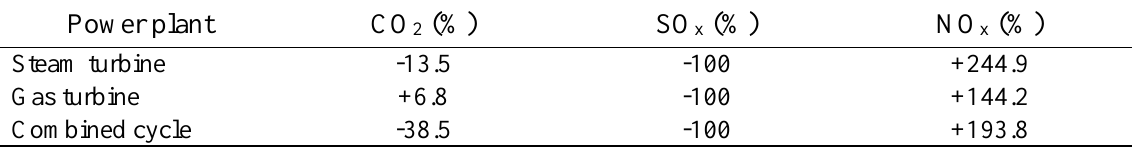
Table 7. Estimated change in the air pollution